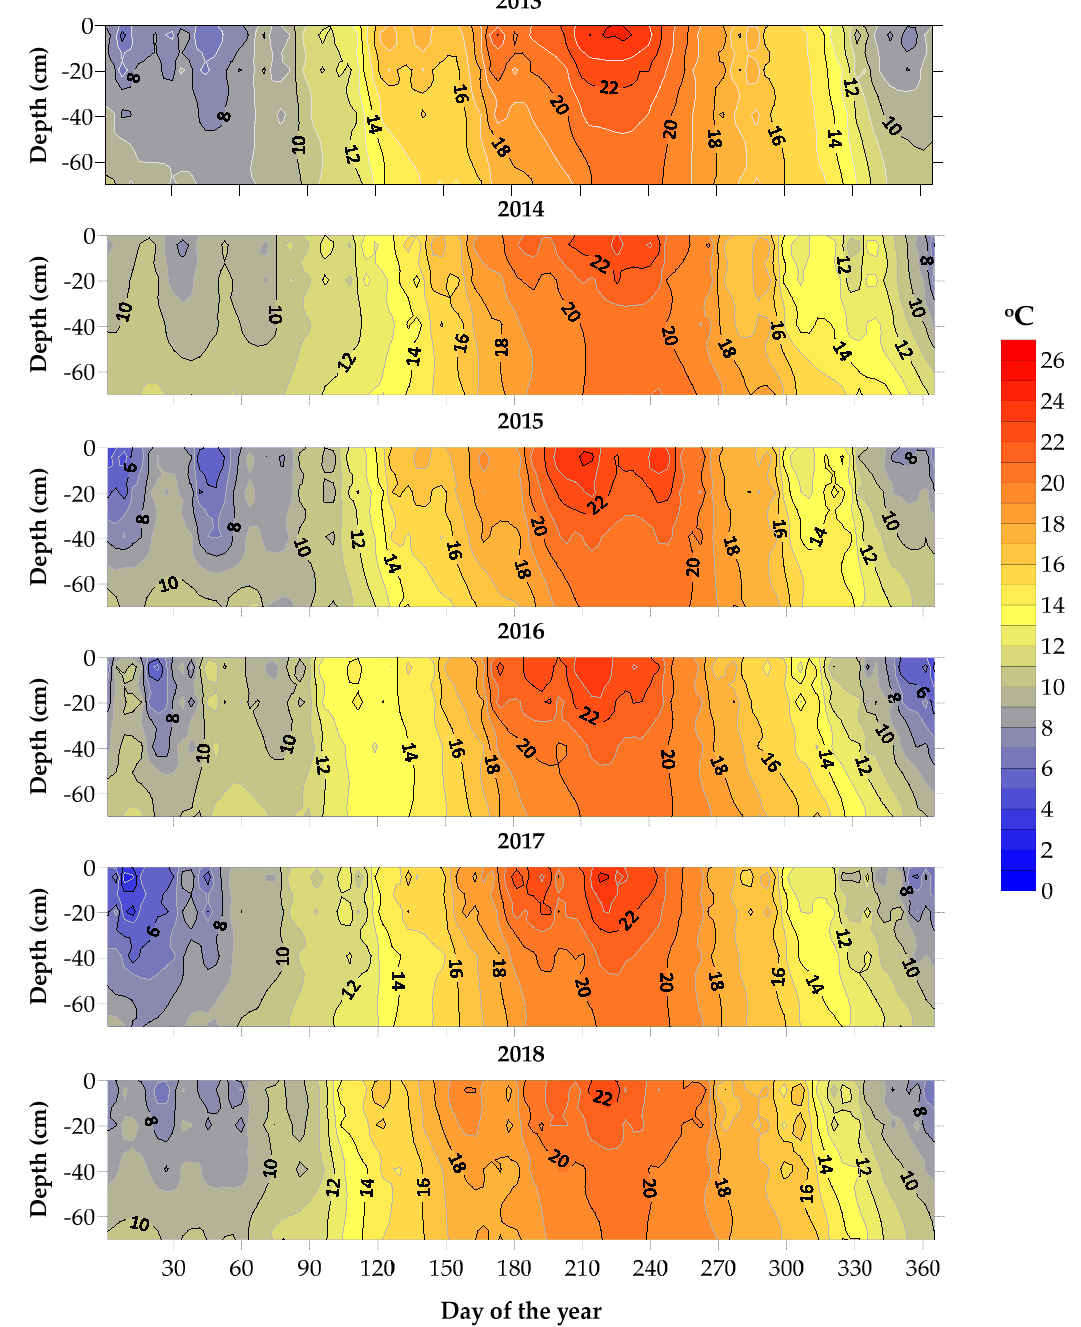
Figure 8. Soil pro fi le temperatures (ST) in °C for the years 2013–2018 based on daily values. Figure 8. Soil profile temperatures (ST) in ◦ C for the years 2013–2018 based on daily The simulation also con fi rms the fi nding that the largest ST variation occurs up to the depth of about 40 cm. According to Terradas and Save [39], transpiration rates showed a linear signi fi cant decline with decreasing soil temperature, and Lloyd and Taylor [27] found that the e ff ective activation energy for respiration varies inversely with T av . Com- bining these fi ndings with our results we can conclude that respiration rates are higher in the upper layers, independently from the root mass. Nevertheless, this is a case for further investigation. Even though the shading of the soil due to the presence of vegetation is strong (LAI = 5.84), at least in the fi rst 20 cm the temperature response is signi fi cantly a ff ected.